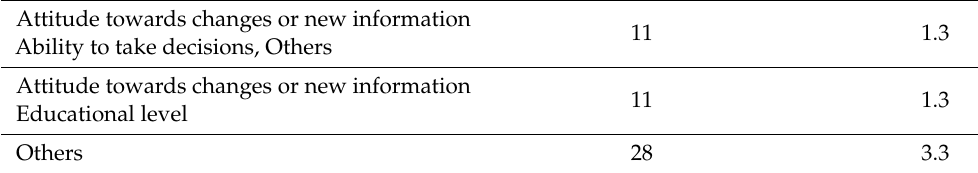
11 1.3 Do they use any method? %